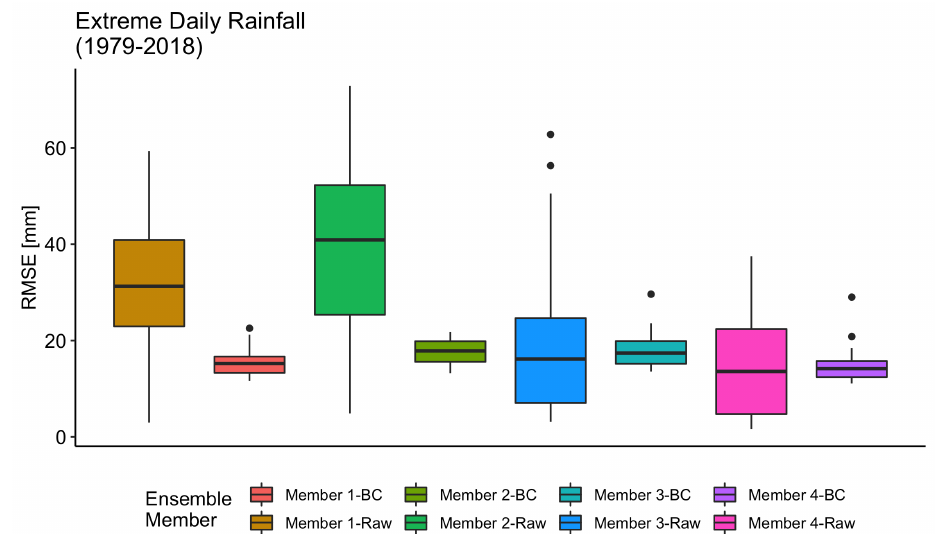
Figure 10. Box plots of root-mean-squared errors (RMSE) of pixels across the study area comparing raw RCM outputs and bias-corrected (BC) RCM outputs of RCM pixels compared to CMFD pixels for extreme daily rainfall for each ensemble member combination in Table 1. The center horizontal line shows the median, the colored boxes show the central quartiles, the whiskers extend to the first and the fourth quartiles, and the colored dots are outliers.